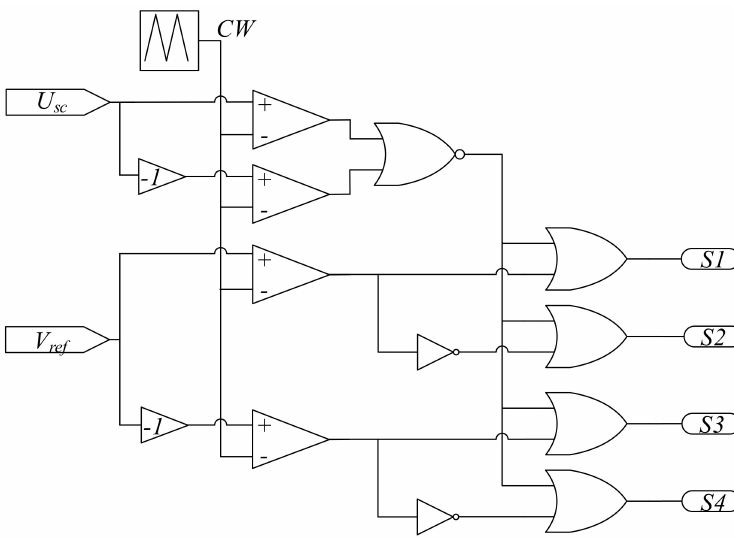
Figure 6. Implementation of simple boost switching